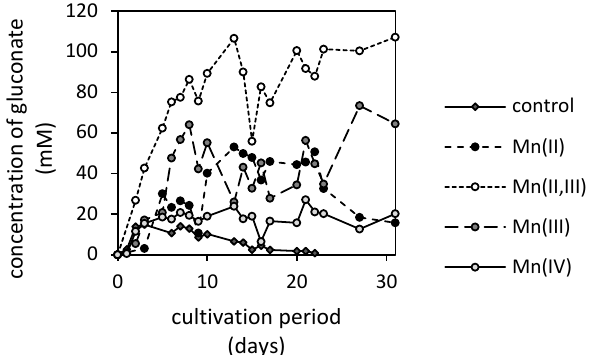
Figure 6. Changes in acetate concentration in culture medium supplemented with Mn(IV)-oxide (MnO 2 ) incubated in the presence of Aspergillus niger for 31 days. The concentration of acetate in other treatments was below the detection limit (0.004 mM) of applied analytical procedure.